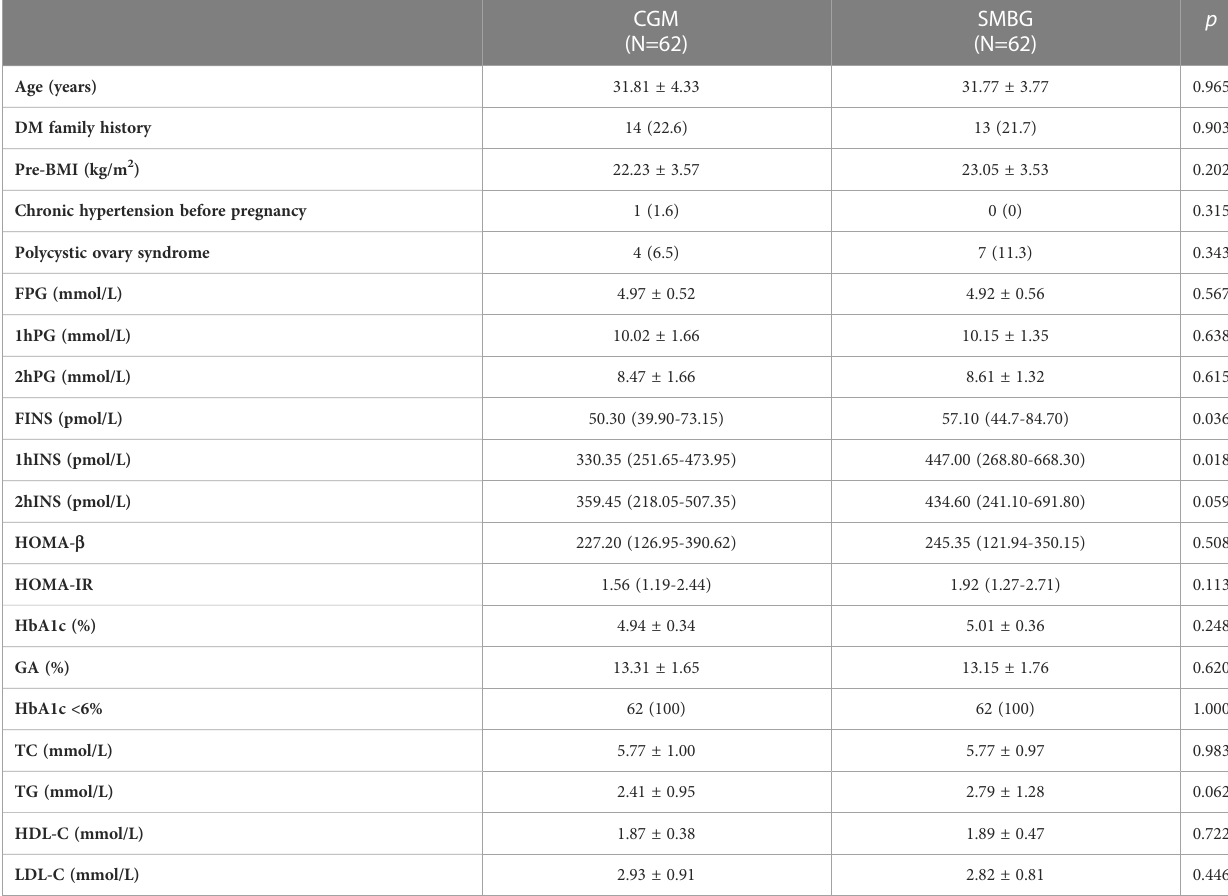
TABLE 1 Demographic and metabolic characteristics of GDM patients at baseline.